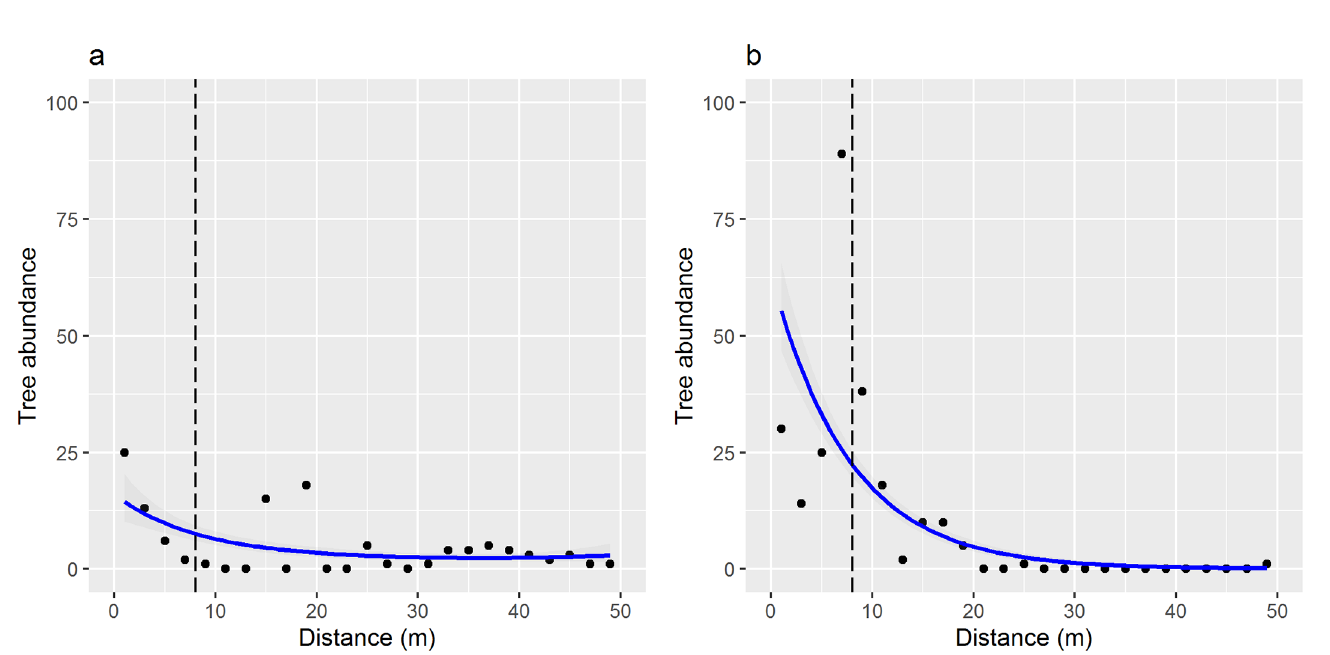
Fig 4. Gleditsia triacanthos seedling abundance with increased distance from mature parent trees in (a) grazed and (b) all other habitats. The fitted lines follow a negative exponential pattern. The dashed line in the graphic represents the tree drip line, which is the distance between the trunk and furthest extension of branches. The drip line represents an approximate maximum dispersal distance for passively dispersed seed pods that drop from the tree.